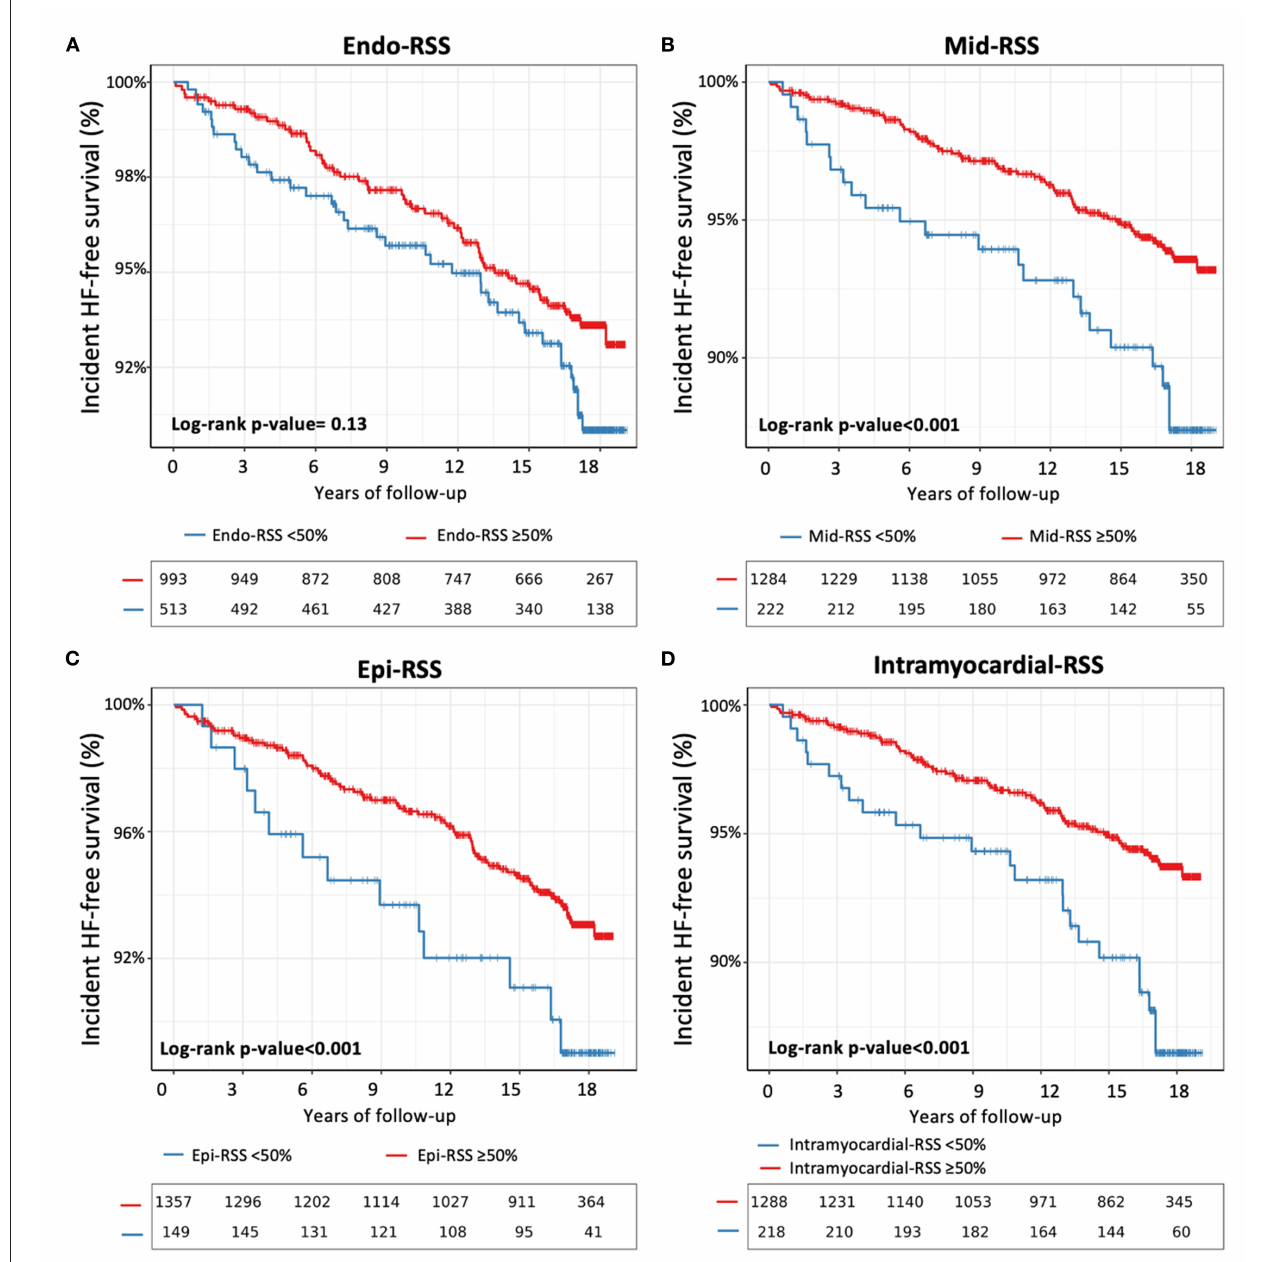
FIGURE 3 | Kaplan–Meier survival curves for incident HF stratified by Endo-RSS < 50% (A) , Mid-RSS < 50% (B) , Epi-RSS < 50% (C) , and intramyocardial-RSS < 50% (D) .